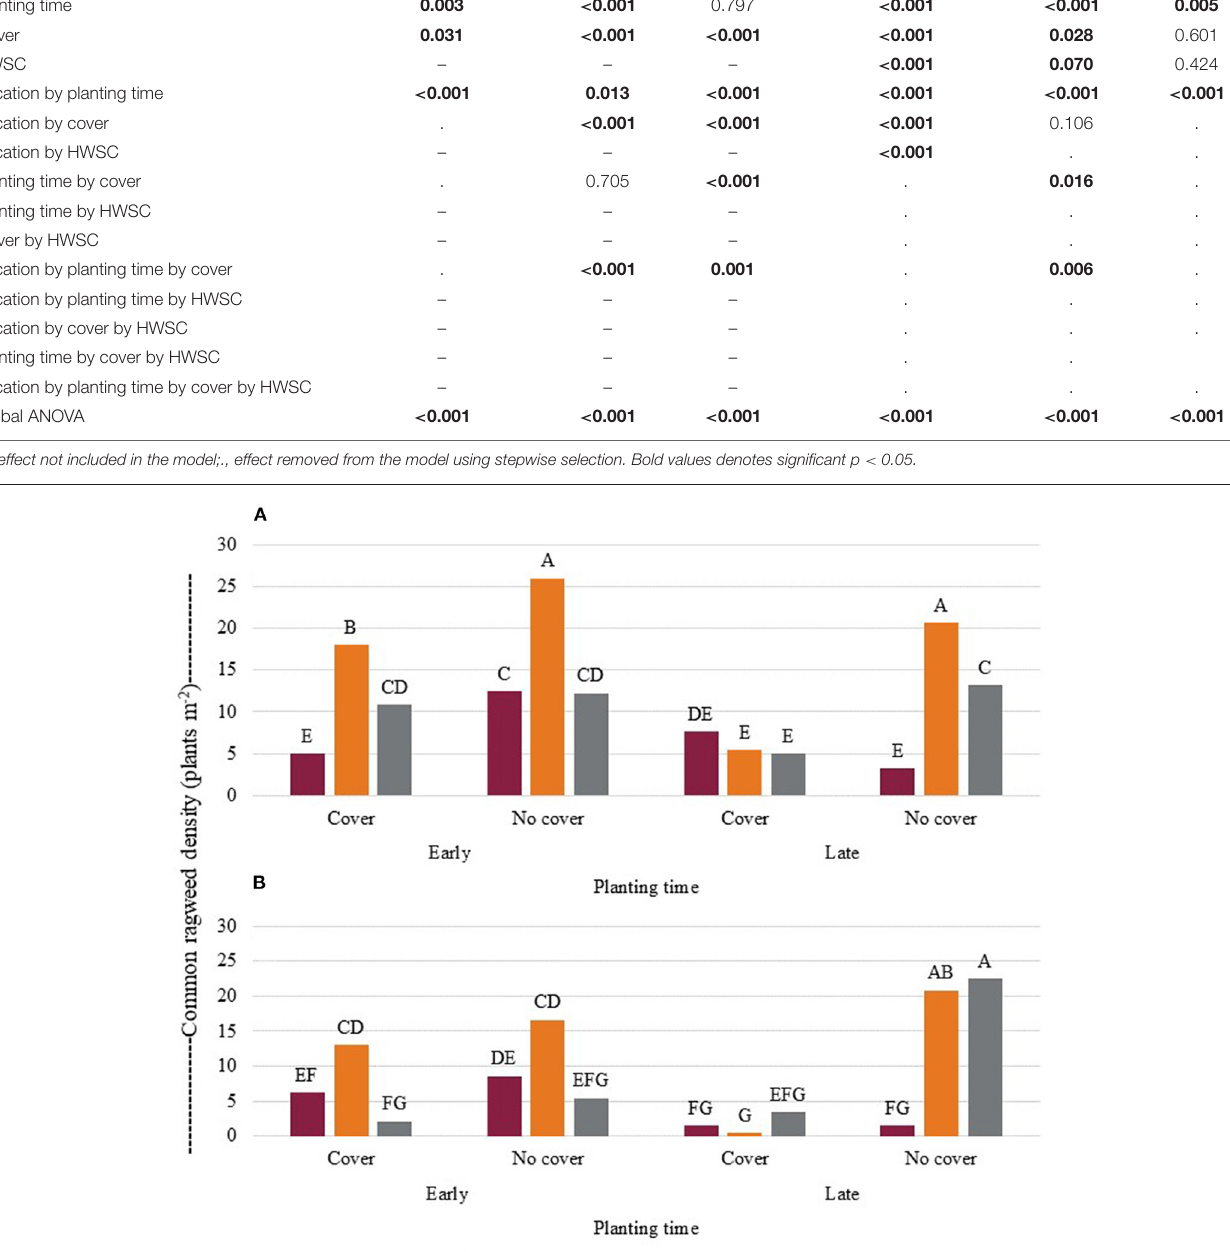
Frontiers in Agronomy | www.frontiersin.org